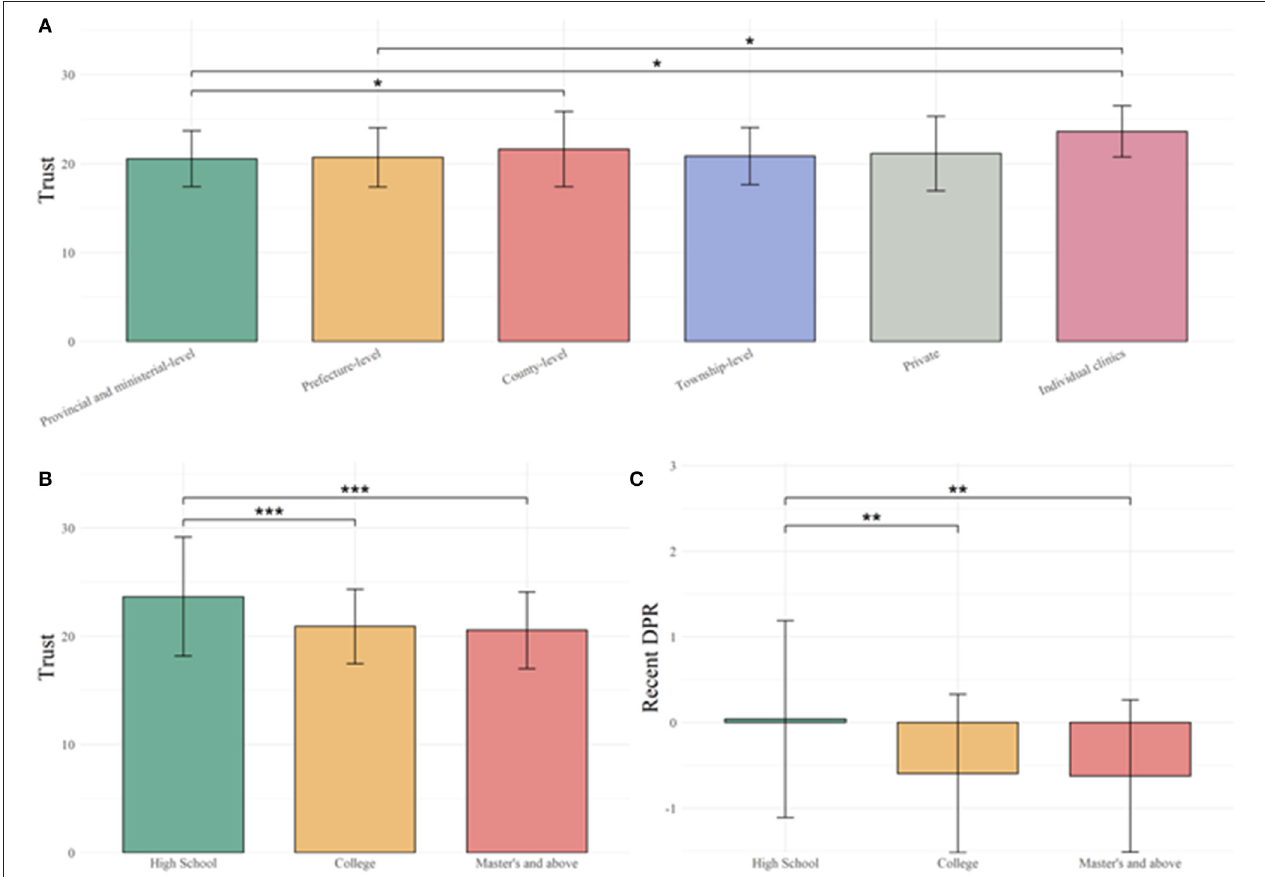
FIGURE 1 | Change in perception of trust in medical services and doctor-patient relationship (DPR) before and during COVID-19. (A) Medical professionals working at prefecture-level and provincial and ministerial-level hospitals have lower trust in patients than those working in individual clinics. Furthermore, medical professionals working at provincial and ministerial-level hospitals have lower trust in patients than those working at county-level hospitals. (B) Medical professionals who have completed high school had higher trust in patients compared to those who have college or master’s degree and above. (C) Medical professionals who have completed high school had positive change in DPR compared to medical professionals who have completed college or master’s degree and above. * < 0.05, ** < 0.01, *** < 0.001.